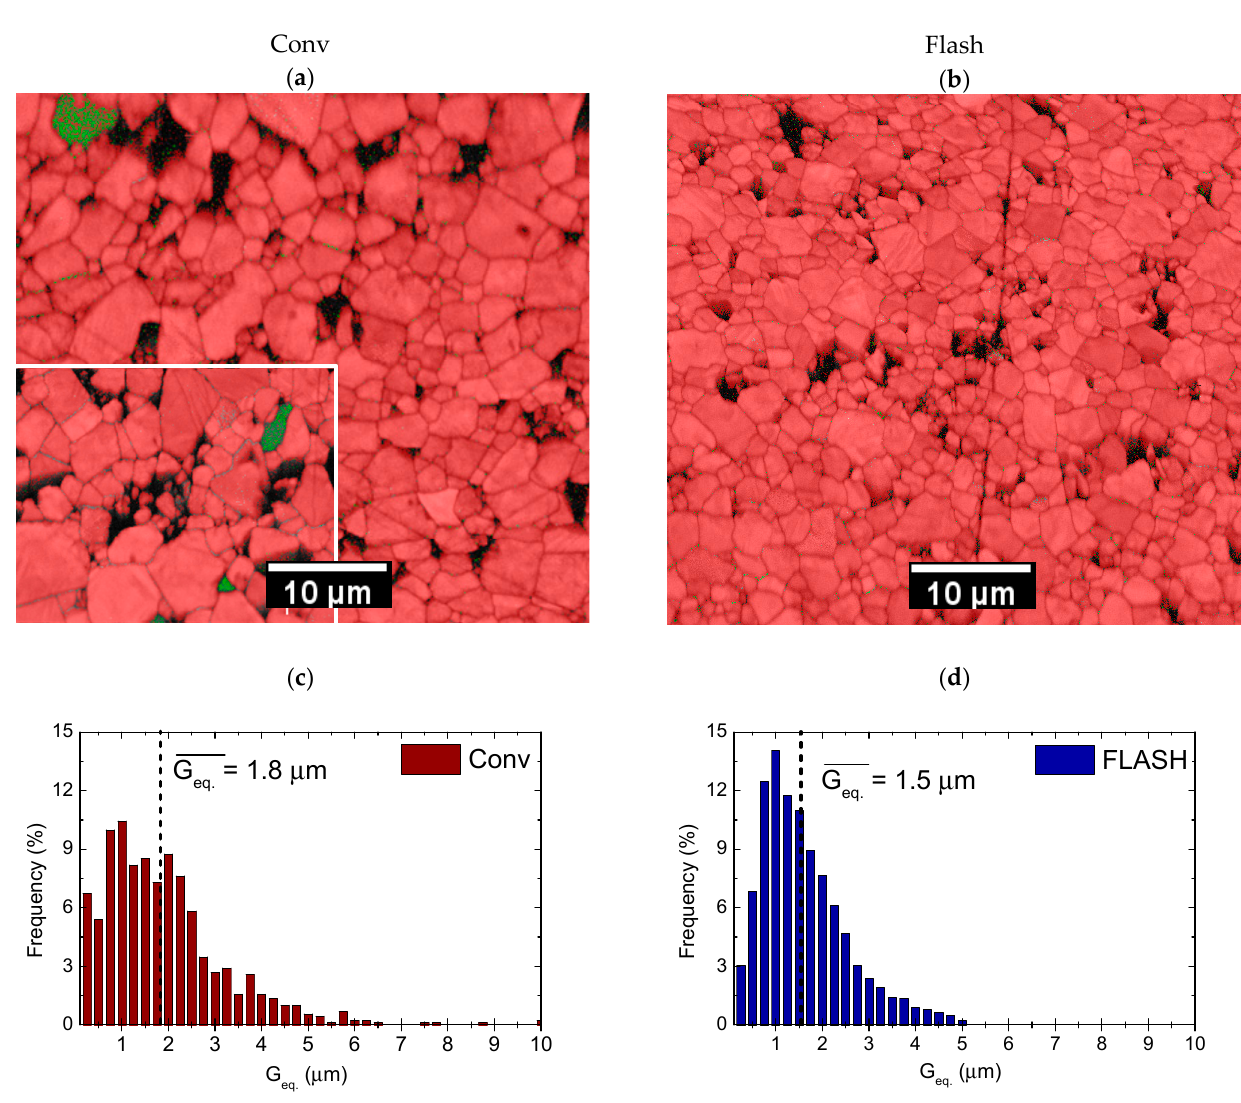
Figure 2. EBSD-phase mapping ( a , b ) and equivalent grain size (G eq. ) distribution ( c , d ) deduced from them for conventional ( a , c ) and Flash ( b , d ) sintered KNN ceramics. Red colour in the maps indicates the indexation with JCPDF file 01-085-7128, K 0.5 Na 0.5 NbO 3 orthorhombic symmetry phase, and green colour with file 04-007-9405, K 0.8 Nb 5 O 15 tetragonal secondary phase. Inset of ( a ) reveals another EBSD mapping for Conv KNN with the secondary phase being systematically indexed in several grains.